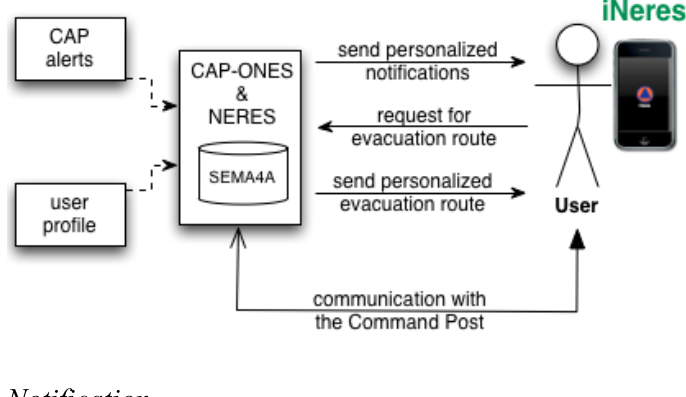
Figure 1. The system architecture for managing personalized alerts and evacuation